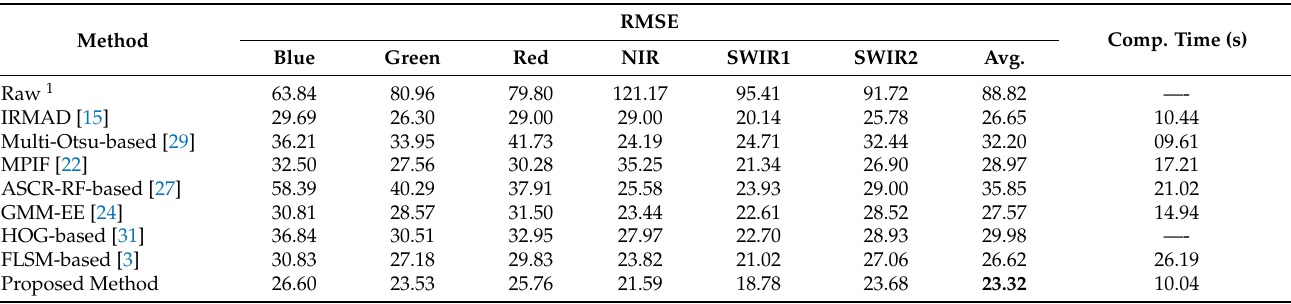
Table 3. Comparison between the accuracy and componential time of different SRRN methods and the proposed method for dataset 1.